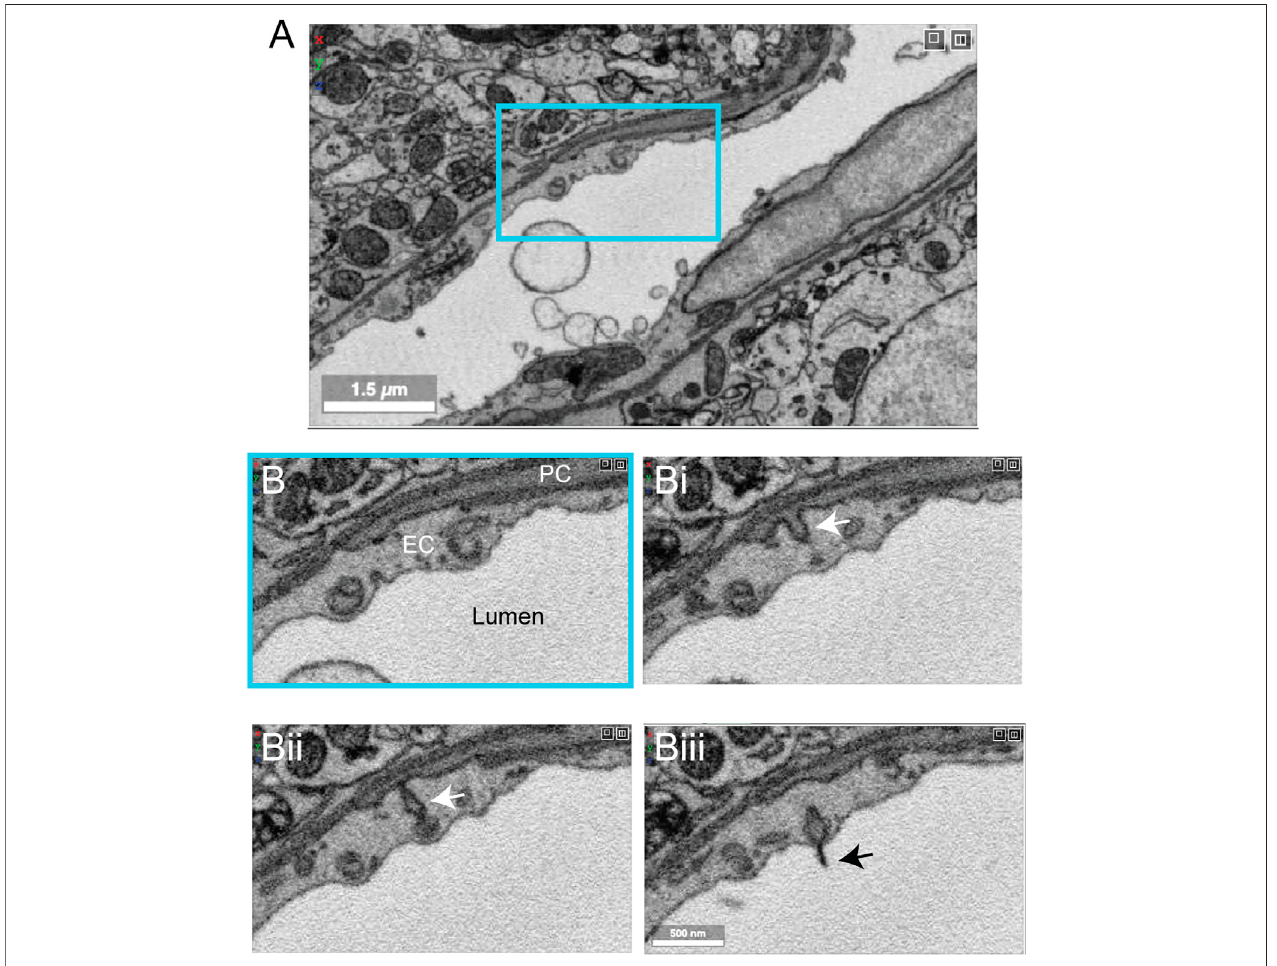
FIGURE 12 | Pericyte projection into vessel lumen in fi nch brain capillaries. (A) A capillary from fi nch basal ganglia (data set: j0251), located at x, y, z coordinates: 19129, 12810, 7,330. (B – Biii) Magni fi ed view of inset in panel A showing a pericyte projecting into the luminal space and ending in a cilia-like structure. The four panels span 10 slices in the z dimension, corresponding to ~200 nm of distance.